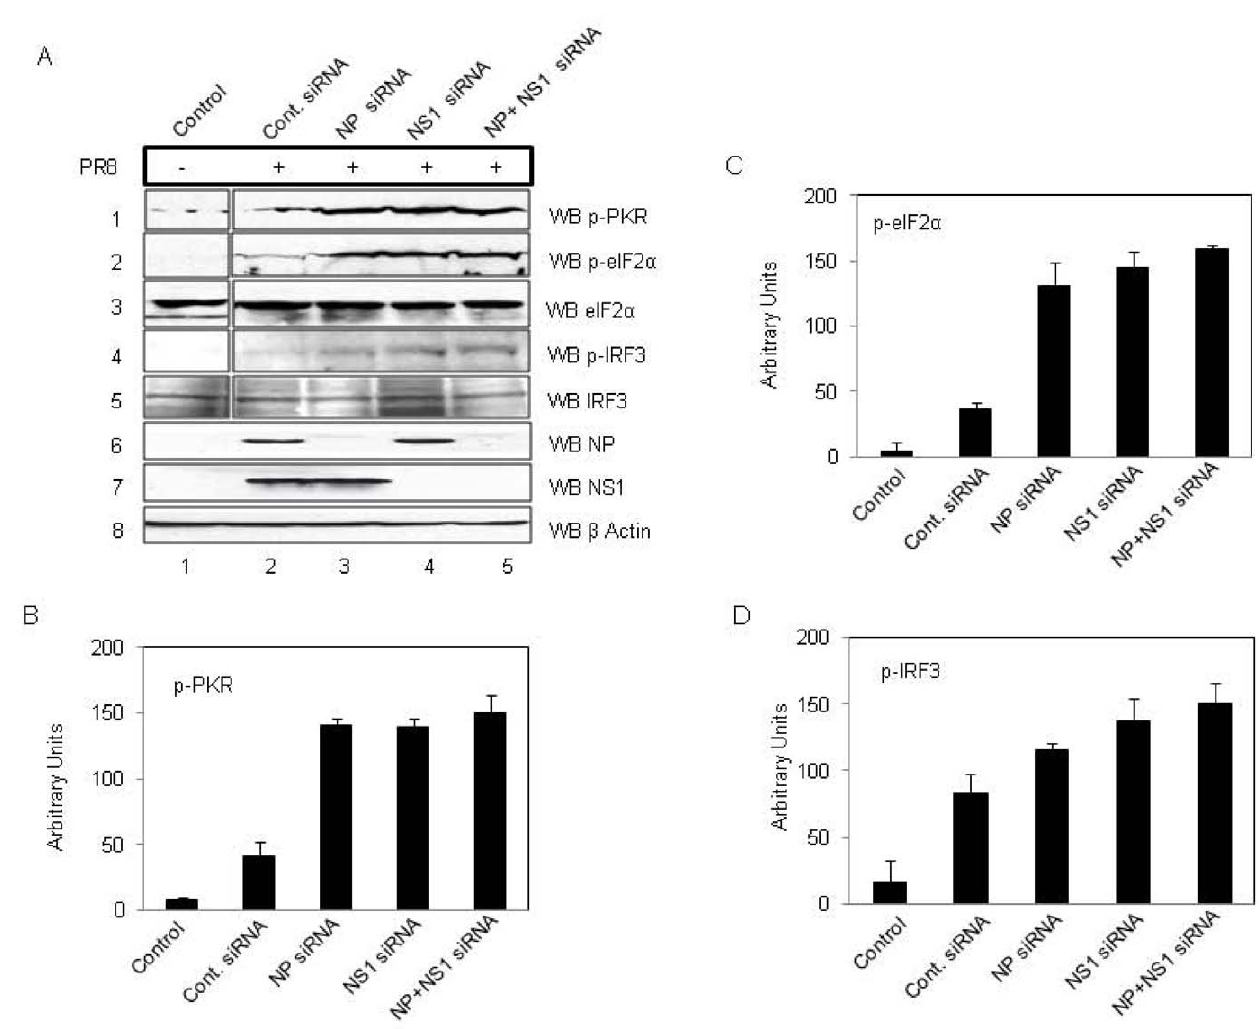
Figure 6. Inhibition of NP expression IAV infected cells upregulates phosphorylation of PKR, eIF2 a and IRF3. A549 cells were treated with siRNA against NP, NS1 or NP andNS1 or control siRNA for 6 hours. Cells were then infected with PR8 virus at an MOI of 1. Cells were harvested at 24 hours post-infection and equal amounts of protein from control and treated cell extracts were subjected to western blot analysis. A. Lane 1 of panels 1, 2 and 4 show control levels of p-PKR, p-eIF2 a and p-IRF3, and lane 2 shows the effect of control siRNA on the same. Lane 3 in panel 1, 2 and 4 shows levels of p-PKR, p-eIF2 a and p-IRF3 levels in case of NP inhibition. Lane 4 shows effect of NS1 inhibition. Lane 5 shows a synergistic effect of NP + NS1 silencing on p-PKR, p-eIF2 a and p-IRF3 levels. Lanes 3 and 5 of panel 6 show the silencing efficacy of NP siRNA and lanes 4 and 5 of panel 7 shows the silencing efficacy of NS1 siRNA. Panel 8 shows equal loading through b -Actin control. B,CandD. Graphs shows relative p-PKR, p-eIF2 a and p-IRF3 levels in virus infected cells pretreated with siRNAs, as measured by western blot followed by densitometric analysis of the protein bands. Plots represent the mean and standard deviation of of three independent experiments.